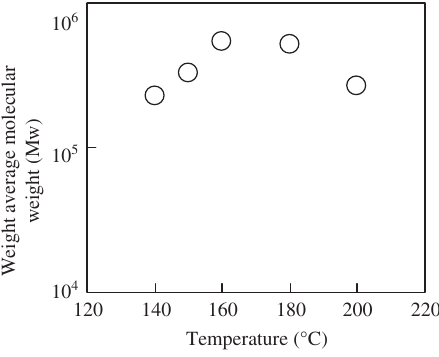
Figure 4 Relation of weight average molecular weight of polyamide 6 to polymerization temperature.